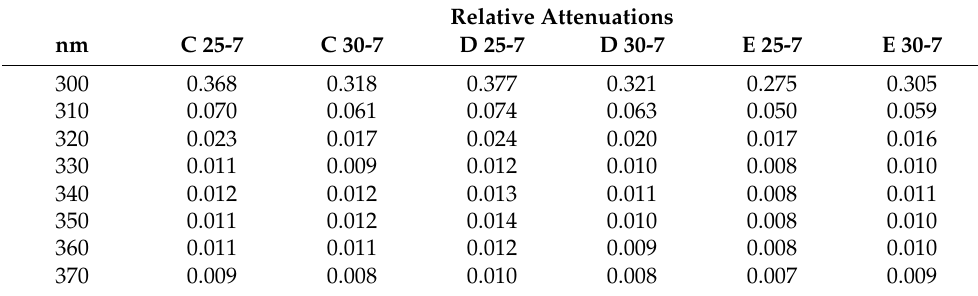
Table 8. Values of the spectral relative attenuations for the UV band for the three interior locations for the two skylight states (25-7 without water and 30-7 with water) at solar noon. Relative